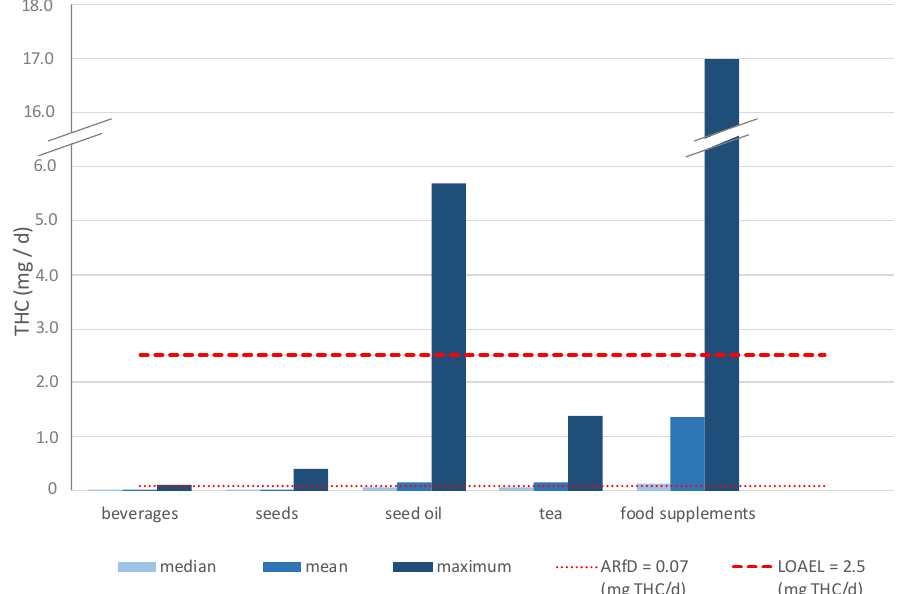
Figure 1. Median, mean, and maximum daily intake of ∆ 9 -tetrahydrocannabinol (THC) from hemp tea, hemp seeds, hemp seed oil, food supplements, and beverages compared to the acute reference dose (ARfD) and lowest observed adverse effect level (LOAEL) for a person with a body weight of 70 kg, assuming the daily consumption shown in Table 2. Data from 2008 – 2021.